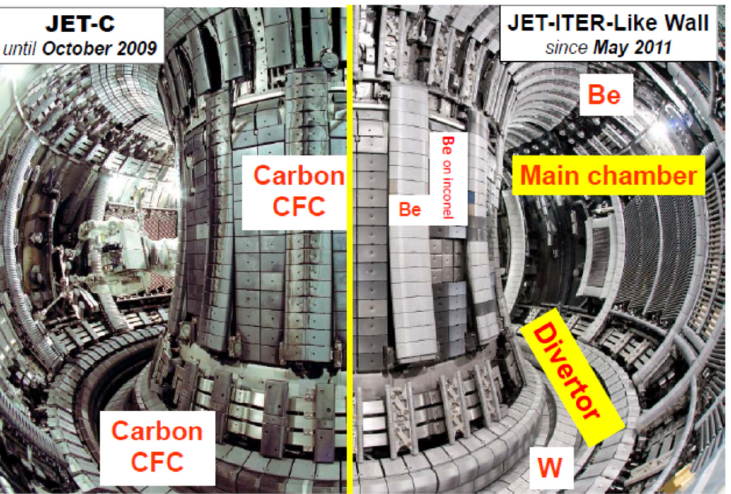
Figure 1. Toroidal view into the vacuum vessel of the Joint European Torus (JET) tokamak. Left : carbon fibre composites (CFC) limiter and divertor tiles in carbon components (JET-C). Right : ITER- Like Wall (JET-ILW) with bulk Be limiters and Be-coated Inconel of the inner wall cladding in the main chamber and bulk W in the divertor base and W-coated CFC tiles in the inner and outer divertor legs. For details about wall materials in JET-ILW, see